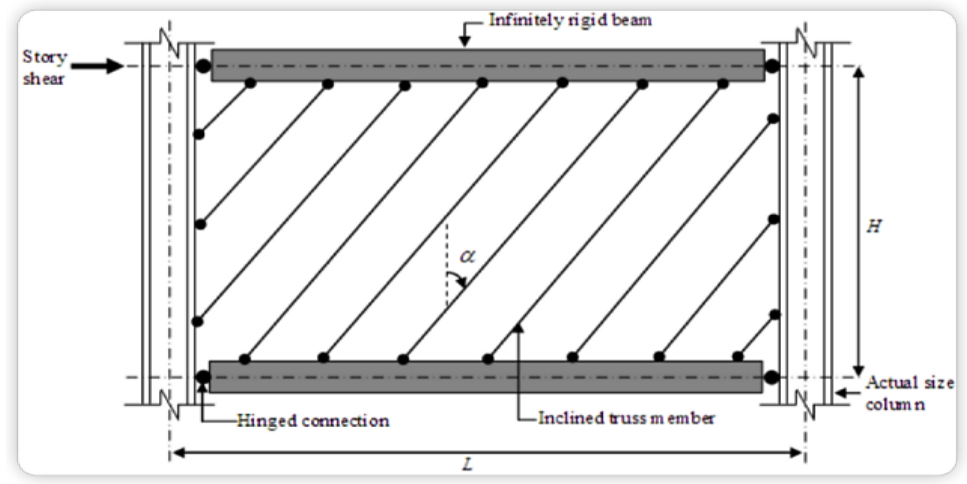
Figure 1. Multistrip Model.